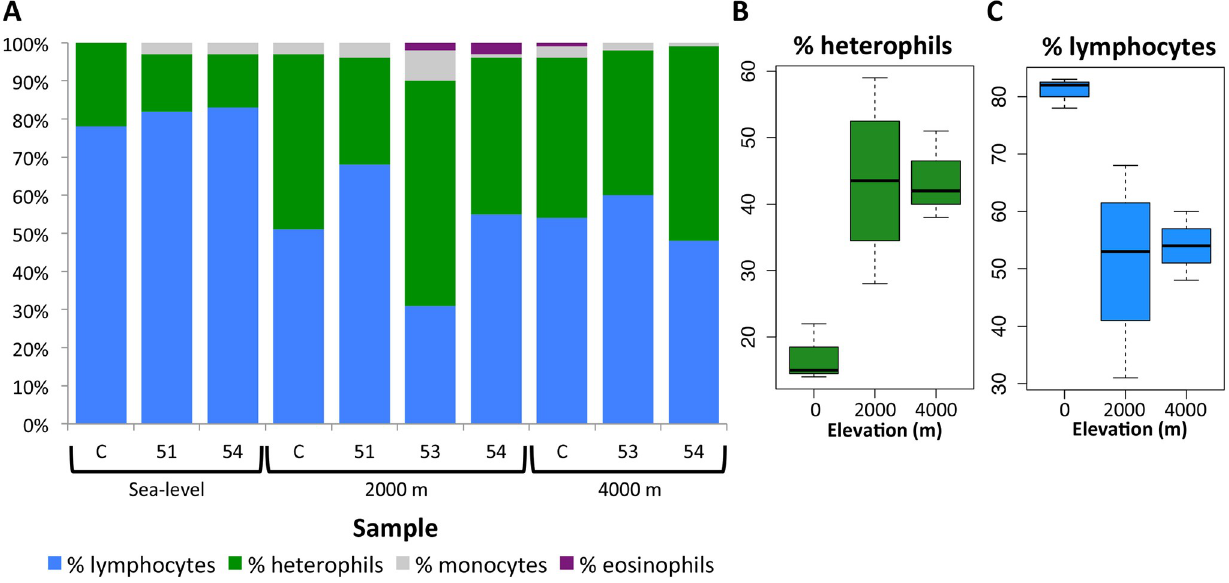
Fig 4. White blood cell composition calculated from blood smears. A) The composition of white blood cells for each of the 10 samples for which we have blood smears. B) Box-plot showing heterophil percentage grouped by elevation. C) Box-plot showing lymphocyte percentage grouped by elevation.